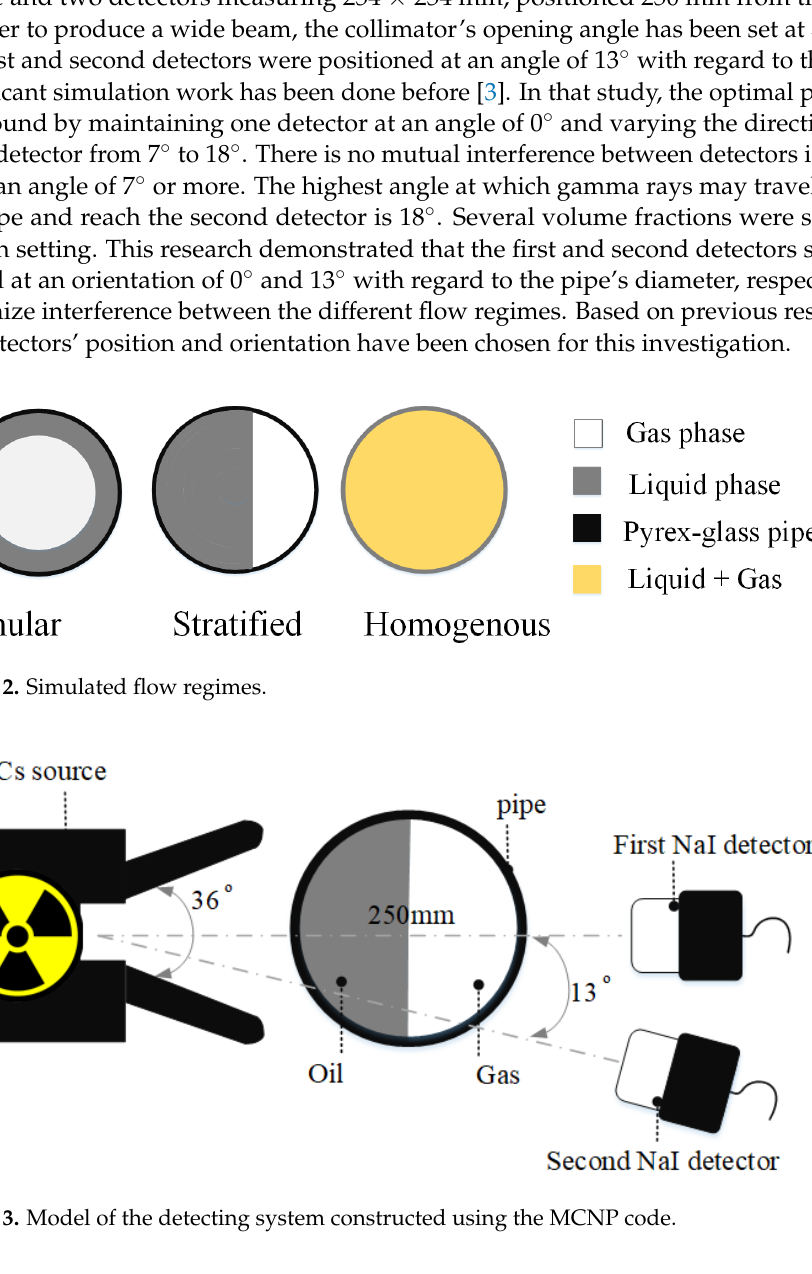
Figure 3. Model of the detecting system constructed using the MCNP code.